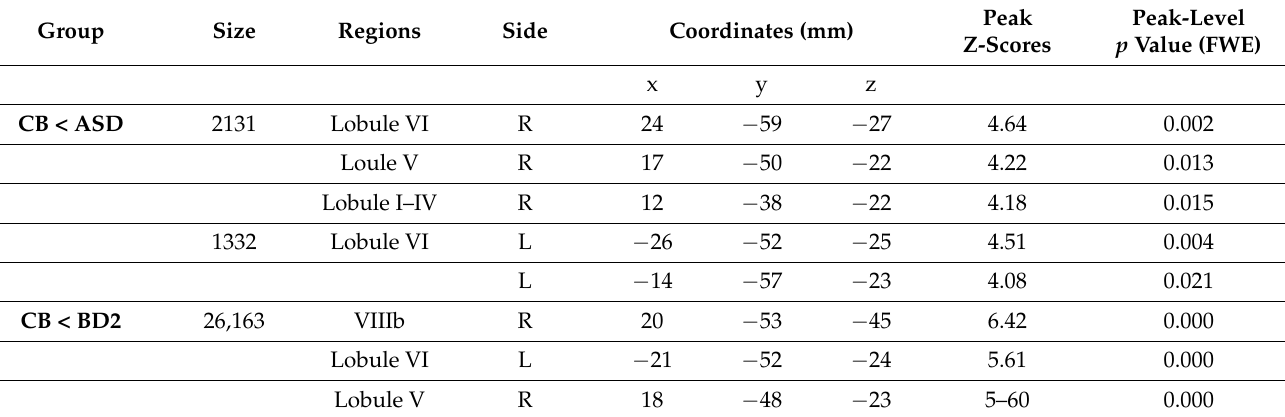
Figure 3. Voxel-wise ANOVA on cerebellar GM density. Cerebellar regions showing patterns of significantly reduced GM in CB compared to ASD ( A ) and BD2 ( B ) are reported and superimposed on the Spatially Unbiased Infratentorial Template (SUIT) [100] in coronal (y), axial (z), and sagittal (x) sections. The results were significant at p -values < 0.05 after familywise error (FWE) cluster-level correction. The images are presented according to neurological convention. Table 4. Between-groups ANOVA showing cerebellar GM reduction in CB compared to ASD and BD2.